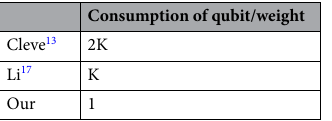
Table 2. The cost of multi-dimensional quantum state.